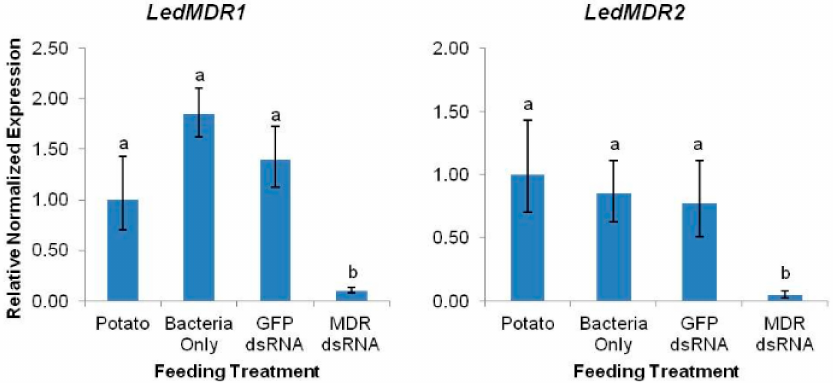
Figure 2. Expression levels of LedMDR1 and LedMDR2 in adult L. decemlineata fed with dsRNA. Expression was measured in combined midgut, head, and MT tissues after three days of feeding on the indicated treatment. Bars represent the mean normalized fold expression ( ± SEM, n = 6) relative to expression in insects fed with potato. Di ff erent letters represent significantly di ff erent expression levels within each gene (Tukey’s HSD, p <